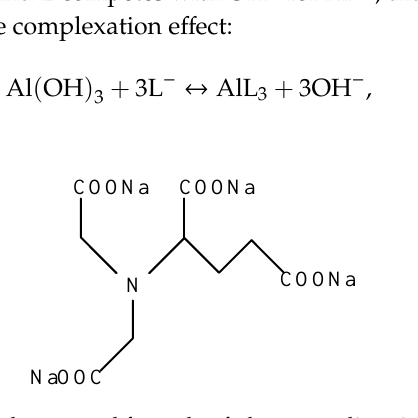
Figure 2. Chemical structural formula of glutamate diacetic acid (GLDA).